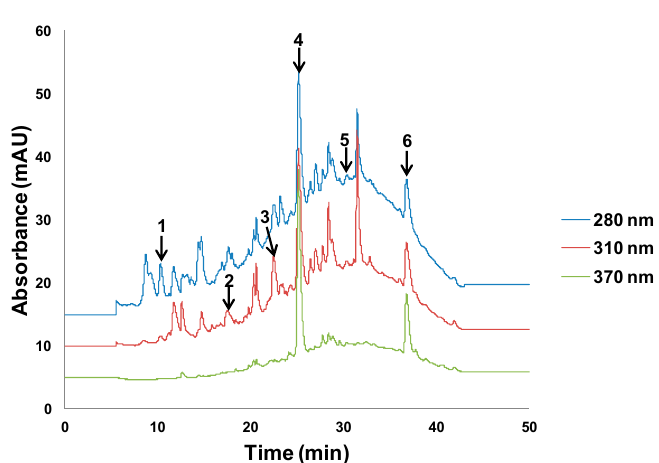
Figure 2. Olive pomace chromatograms at 280, 310, and 370 nm. Peak assignment: 1—3-hydroxytyrosol, 2—ca ff eic acid, 3— p -coumaric acid, 4—rutin, 5—oleuropein, 6—luteolin.